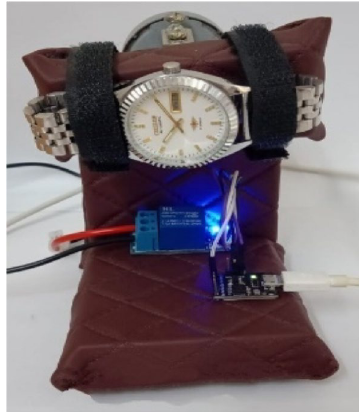
Fig. 7 Prototype of the proposed winder